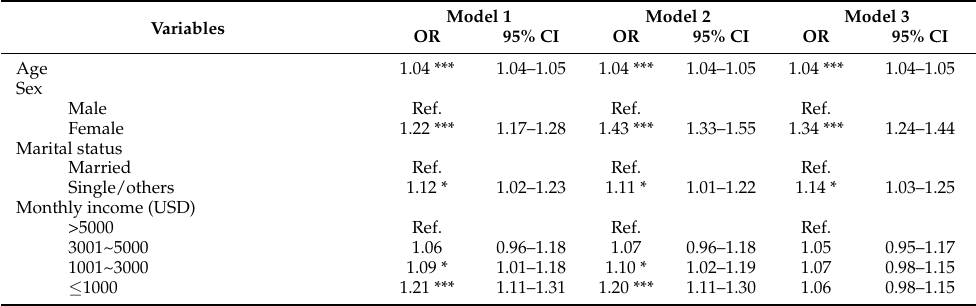
Table 4. Factors influencing subjective cognitive impairment among older